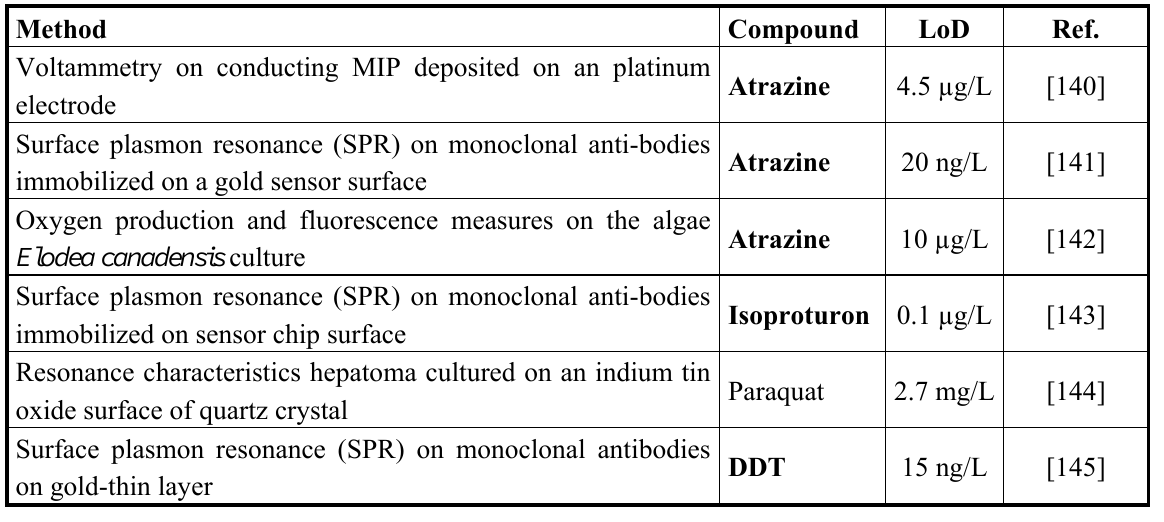
Table 12. Micro-sensors for pesticide determination in water, other than organophosphate and carbamates. WFD priority organic substances in bold type.